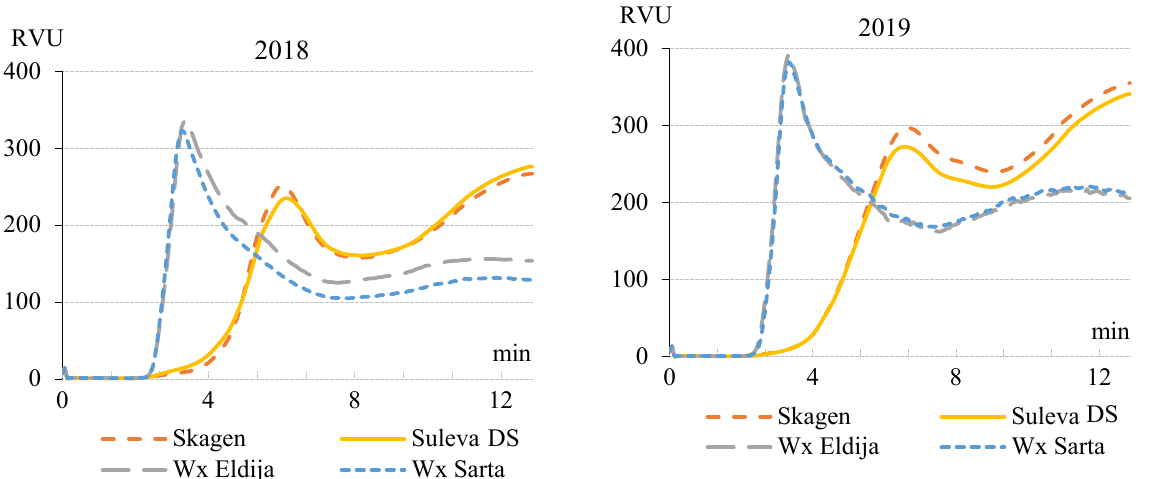
Figure 4. Grain starch content ( A ) and A-type starch volume ( B ) of non-waxy (‘Skagen’, ‘Suleva DS’) and waxy (‘Eldija’, ‘Sarta’) winter wheat cultivars grown under different farming systems (L—low-input, I—intensive) in two cropping seasons. Values in columns followed by the same letter are not significantly different at p < 0.05.